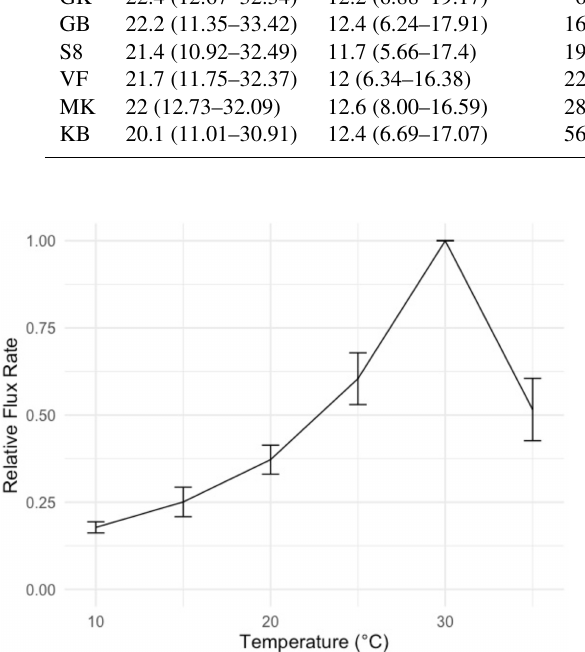
Figure 2. Temperature sensitivity of respiration from S. sabulicola tillers in a laboratory incubation, used to constrain temperature pa- rameters (mean ± 1 S.E.M., n = 8). Flux rate is normalized to the rate at 30 ◦ C. Tillers were sprayed with deionized water until satu- rated and respiration was measured at 5 ◦ C